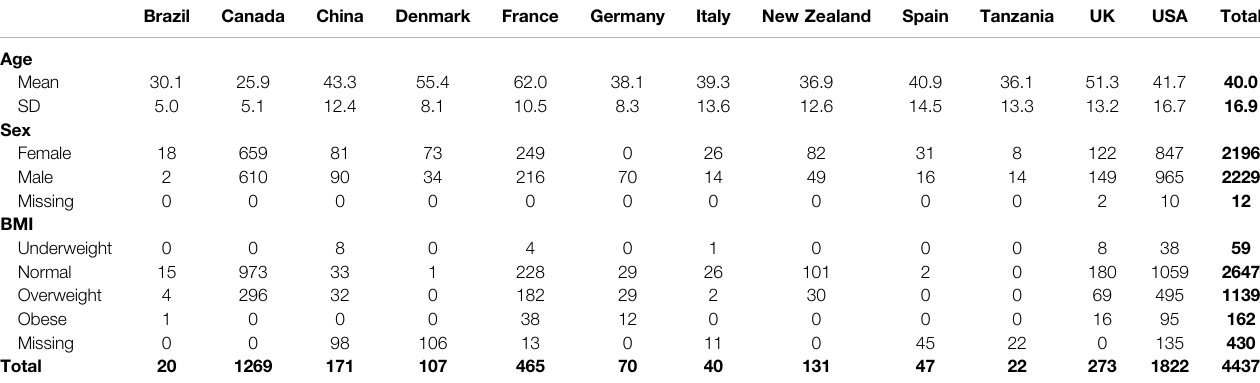
TABLE 1 | Demographic